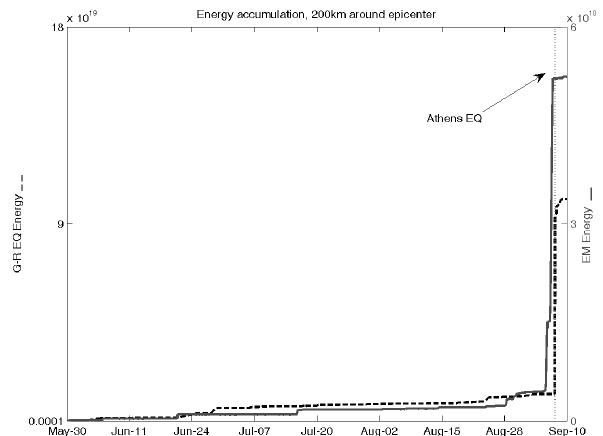
Fig. 9. Time evolution of the EM (continuous line) and seismic (broken line) energy release accumulation. The grey dotted line indicates the time of the Athens EQ occurrence.